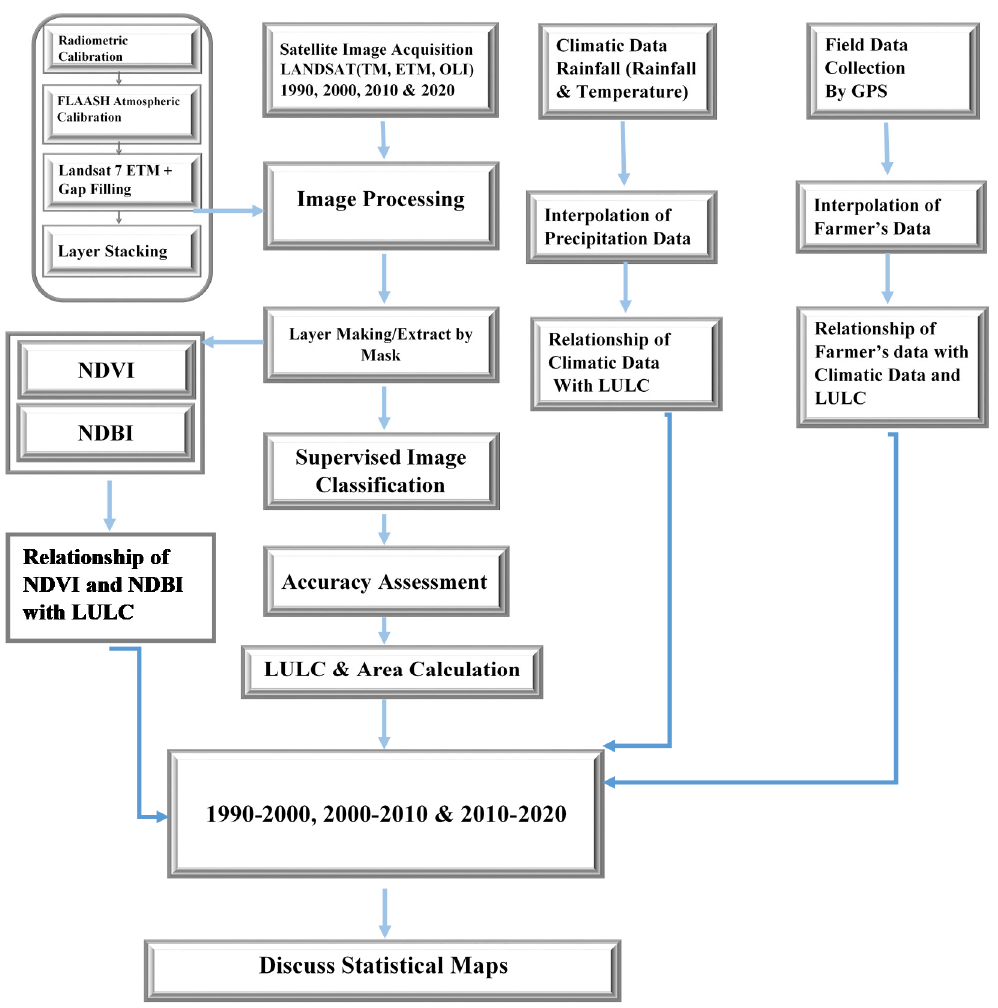
Figure 3. Flow chart for the methodology.